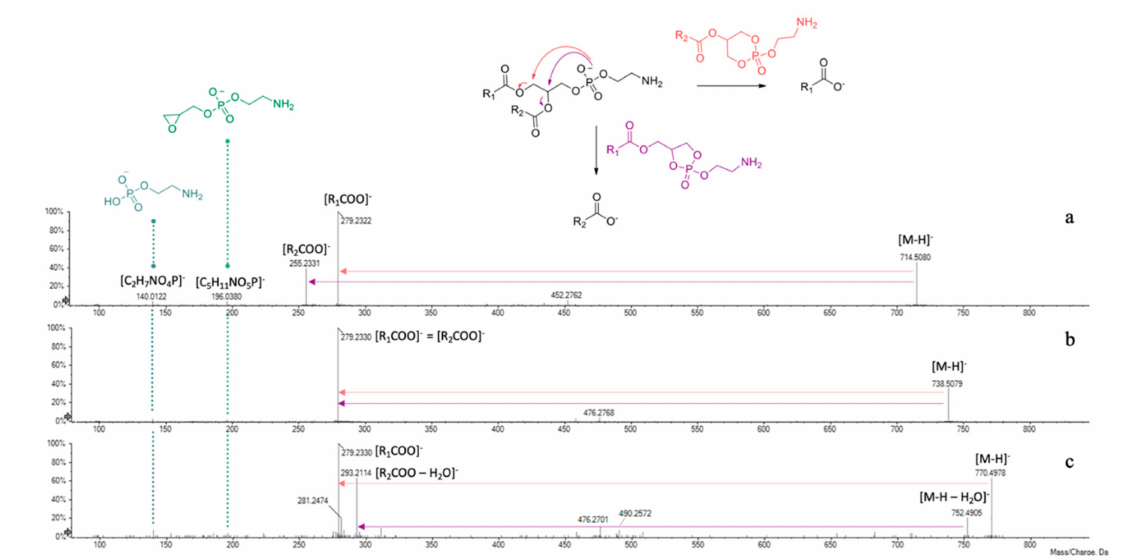
Figure 6. ESI-TOF/MS 2 spectra of compounds ( a ) 1 , ( b ) 2 and ( c ) 3 and fragmentation scheme of GPE